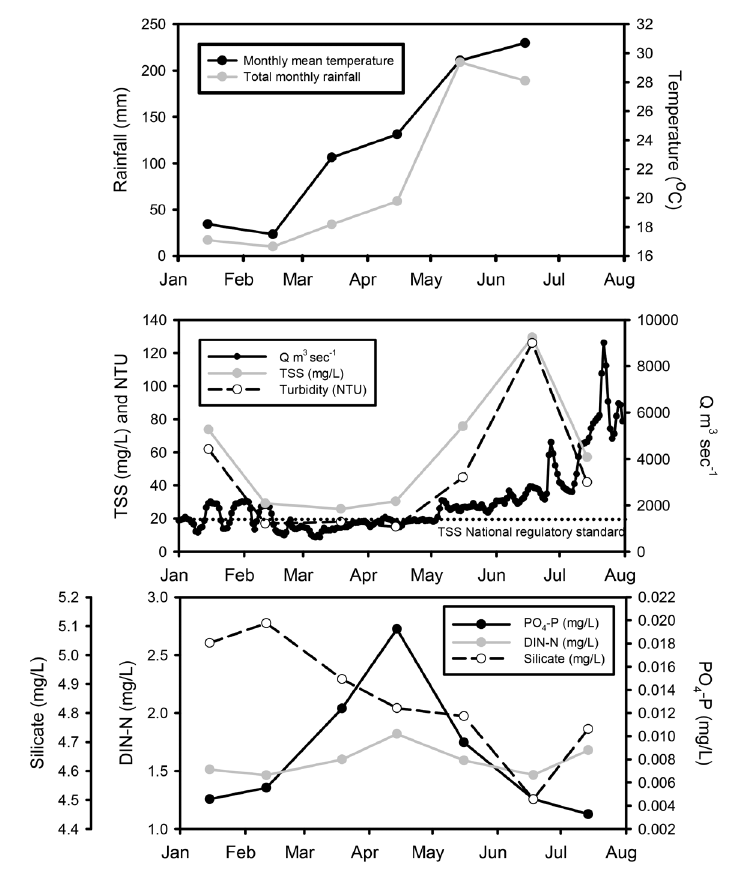
Figure 2 – Total monthly rainfall and mean monthly temperature calculated from daily measurements at Lang Station in Hanoi. Daily river discharge, and monthly turbidity measured at Hanoi hydrological station; total suspended solids (TSS) and turbidity (NTU) silicate (DSi), dissolved inorganic nitrogen and phosphate are also